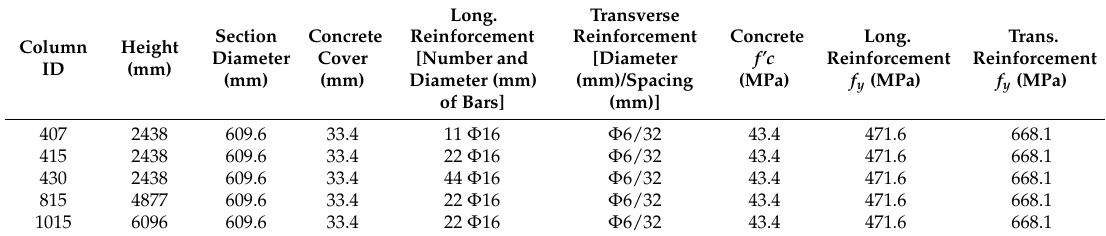
) . Figure 10. Bending Moment Profile M ( z i ) (cid:2919)